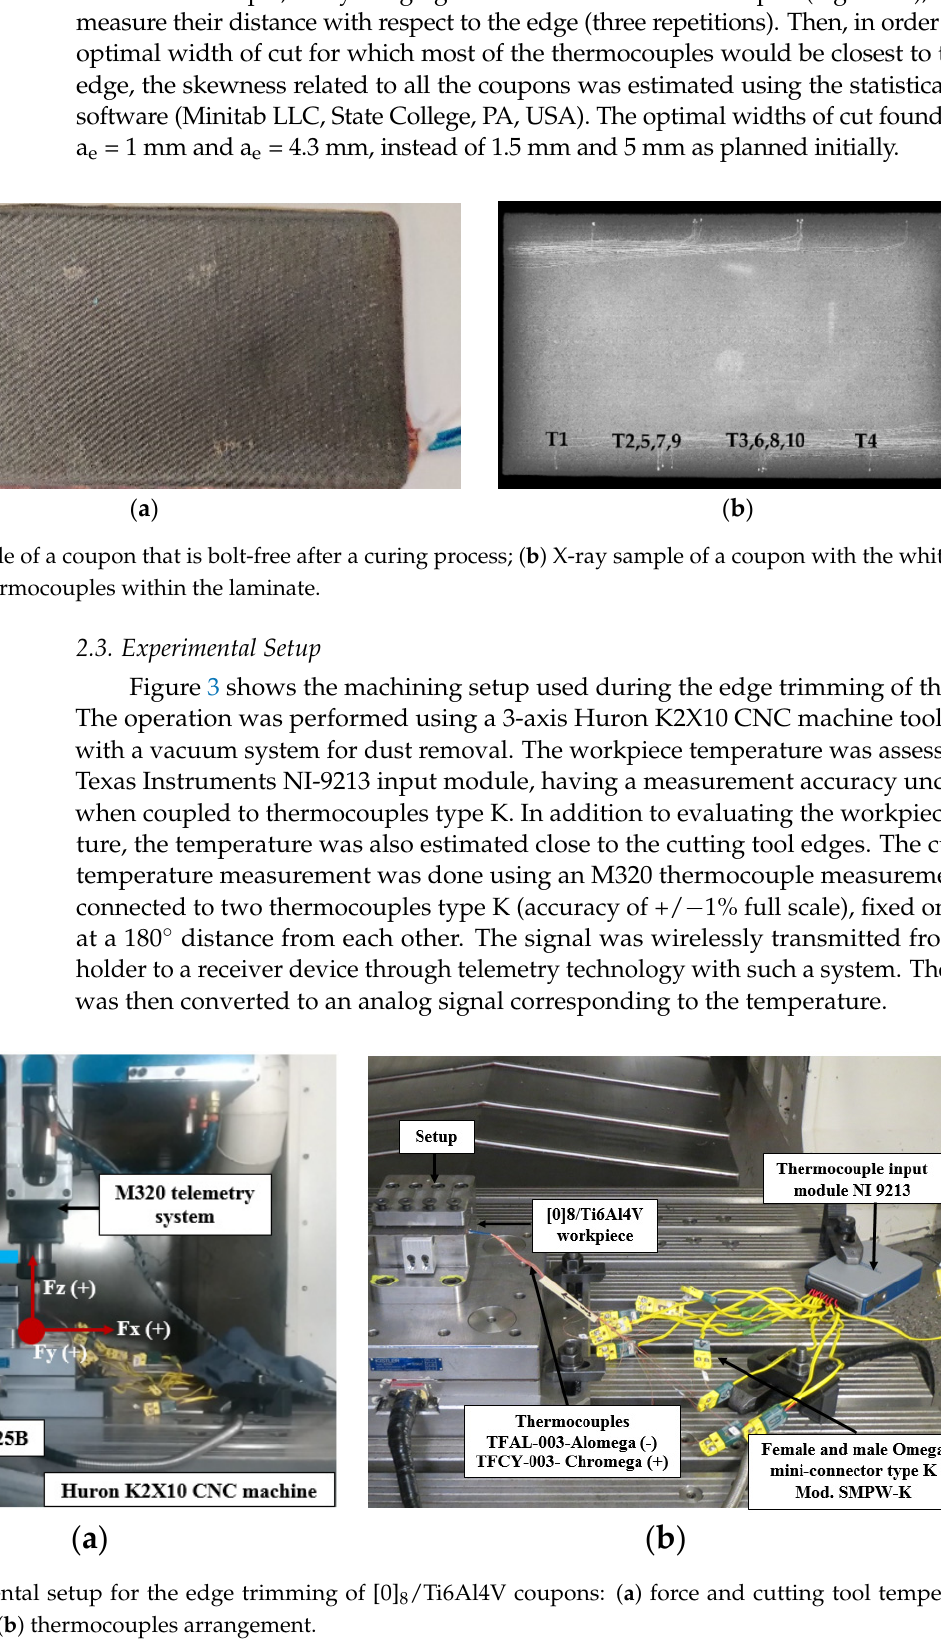
Figure 3. Experimental setup for the edge trimming of [0] 8 /Ti6Al4V coupons: ( a ) force and cutting tool temperature acquisition system; ( b ) thermocouples arrangement.